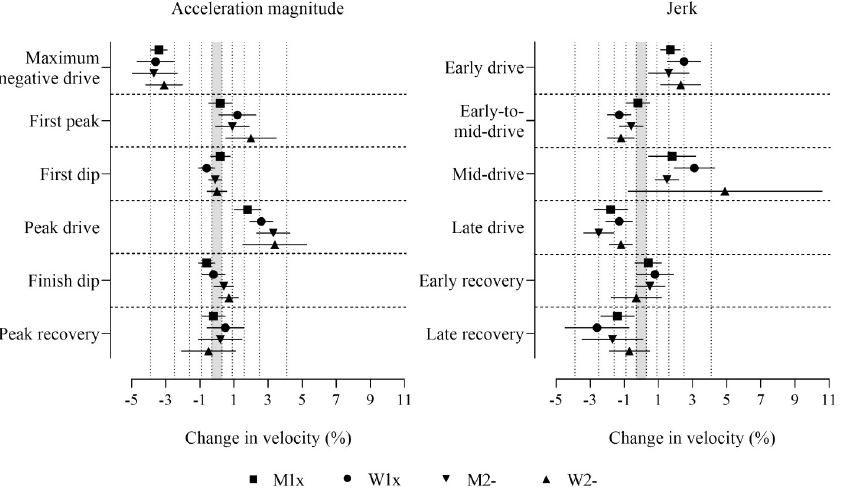
Fig 4. Change in boat velocity for a change in predictor variables of two within-crew standard deviations with adjustment for stroke rate. Data are mean (%) and 90% compatibility intervals. The shaded grey area covers trivial values (values within the smallest substantial change thresholds, -0.3 to 0.3%). Vertical dotted lines delineate threshold magnitudes of small ( ± 0.3), moderate ( ± 0.9), large ( ± 1.6), very large ( ± 2.5), and extremely large (4.1, -3.9%). Effects with compatibility intervals that do not enter the grey area are decisively (very likely or most likely) substantial. Effects with compatibility intervals that end within the grey area have adequate precision (possibly or likely substantial or